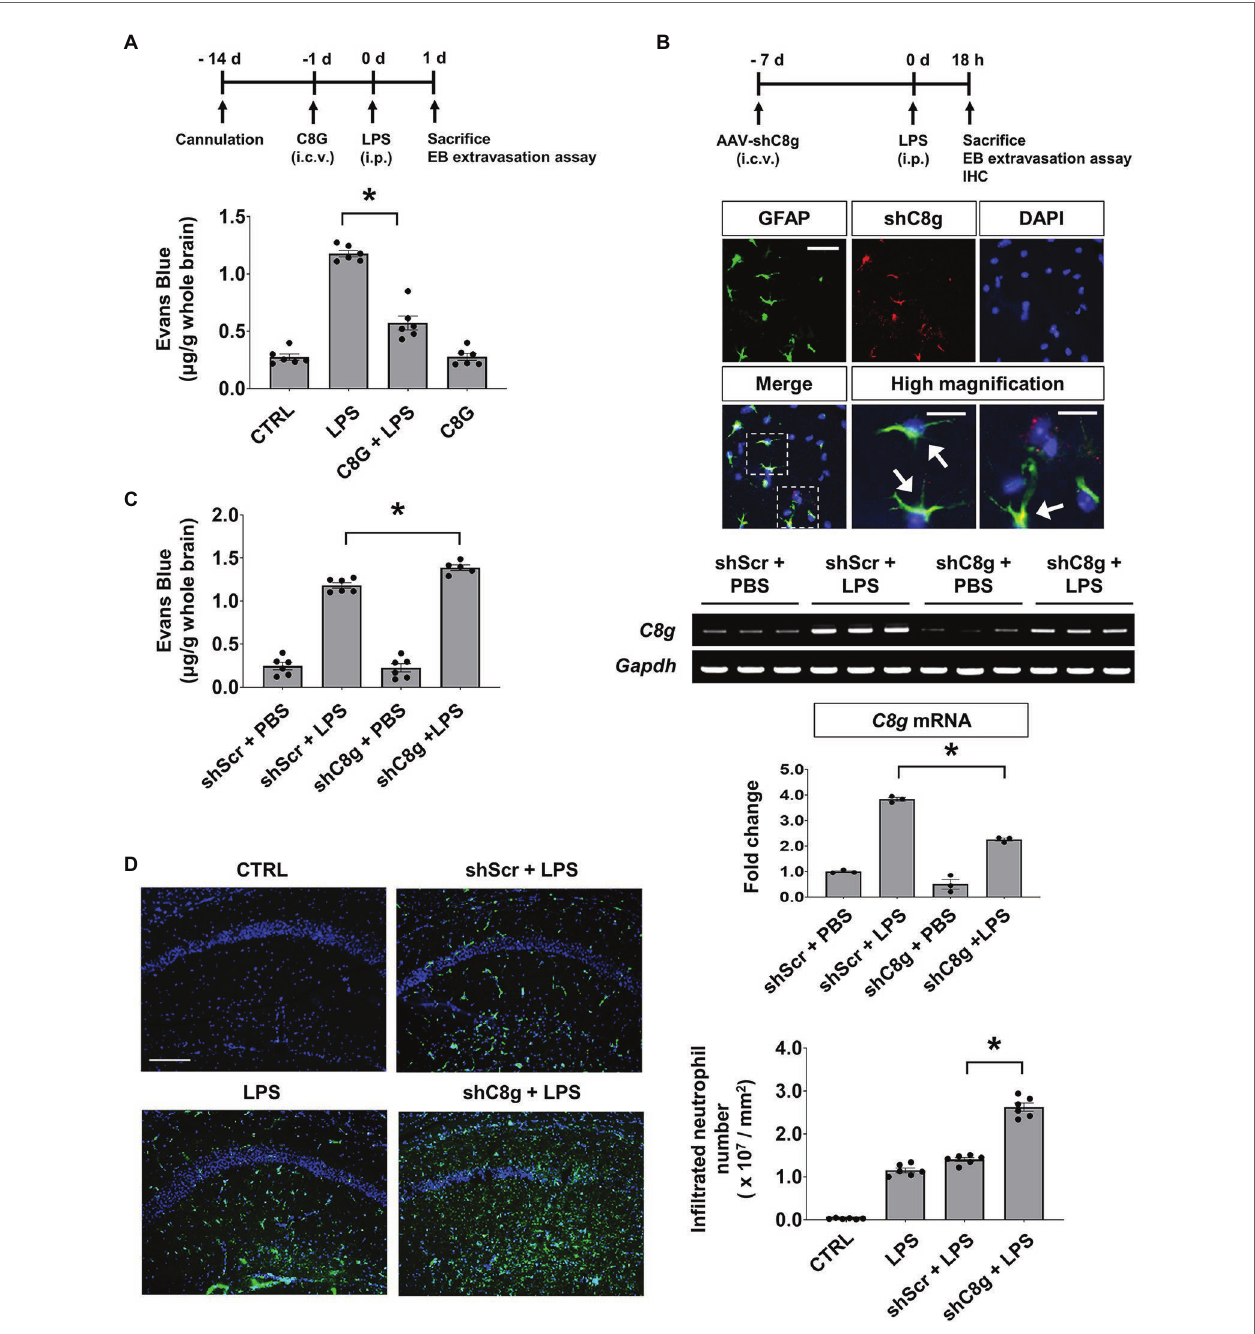
FIGURE 2 | Complement component 8 gamma protects the blood-brain barrier (BBB) in the LPS-induced inflamed brain. (A) The administration of recombinant C8G protein inhibited Evans blue extravasation in the inflamed brain. Recombinant C8G protein (1 μ g/ml) was injected intracerebroventricularly (i.c.v.) through a guide cannula before the intraperitoneal (i.p.) injection of LPS (5 mg/kg). C57BL/6 mice ( n = 6 each) were sacrificed 24 h after the LPS challenge and their brains were removed. Brain vascular permeability was assessed by Evans blue accumulation in the brains, as described in the Materials and Methods. (B) Knockdown of C8G in the brain. Expression of adeno-associated virus (AAV)-shRNA C8g (shC8g, mCherry) in the hippocampus (scale bar, 25 μ m) and high-magnification image of infected cells in the hippocampus (scale bar, 10 μ m). Mice ( n = 3) were given an i.c.v. injection of shC8g (1 × 10 9 TU/ml, 2 μ l) using a stereotaxic device and a microinjector. Brain tissues were stained with an anti-GFAP antibody (green) and DAPI (blue). The arrowheads indicate the co-localization of shC8g with GFAP. Knockdown efficacy was measured by reverse transcription-PCR (RT-PCR; 58.9% in the brain of LPS-injected mice, lower panel). (C) Knockdown of C8G increased Evans blue extravasation in the inflamed brain ( n = 6 each). (D) Knockdown of C8G increased LPS-induced neutrophil infiltration. Infiltrated neutrophils in the hippocampus were immunostained with an anti-LY6G antibody (green) 18 h after LPS (5 mg/kg) i.p. injection ( n = 6 each). Scale bar, 200 μ m. All data are the mean ± SEM. * p < 0.05, Student’s t -test (C) or Tukey’s multiple comparisons test after one-way ANOVA (A,B,D)